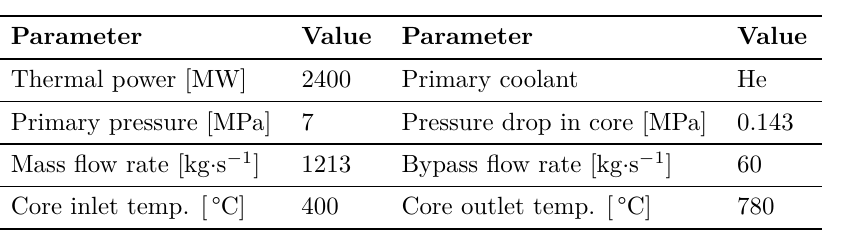
Table 2. Basic thermal-hydraulic parameters [15].